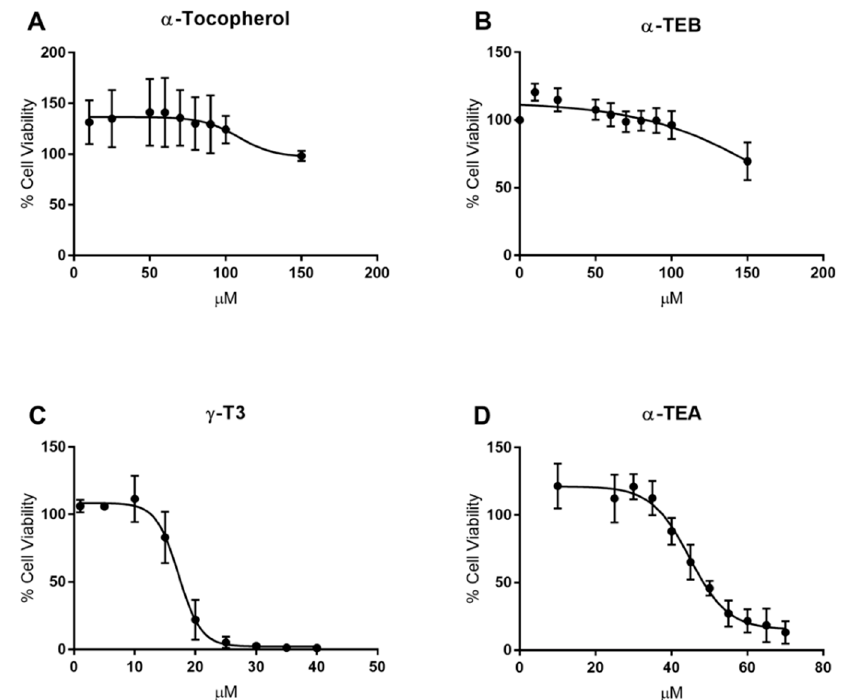
Figure 1. IC 50 graphs for α -tocopherol ( α -TOC), α -tocopherol ether butyrate ( α -TEB), γ -tocotrienol ( γ -T3), and α -tocopherol ether acetate ( α -TEA) in PC-3 human prostate cancer cells. Cell viability at various concentrations over the course of 48 h was assessed for each compound. α -TOC and α -TEB had no effect on cell viability ( A , B ). α -TEA and γ -T3 inhibited cell viability in a dose-dependent manner ( C , D ). IC 50 values for these compounds were calculated with a 95% confidence interval: ( C ) γ -T3, 17.0 ± 1.0 µM; ( D ) α -TEA, 45.0 ± 2.3 µM.